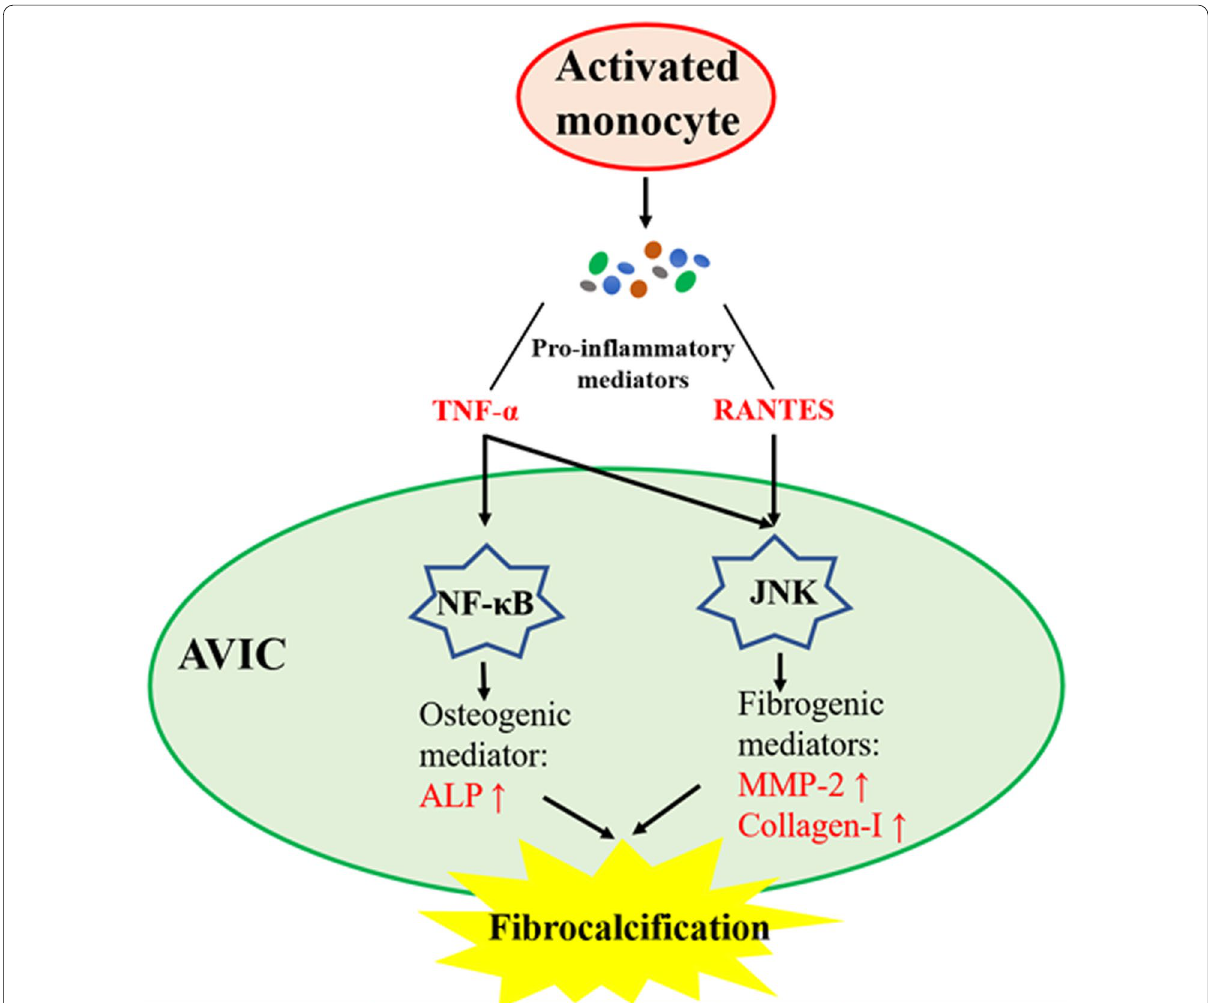
Fig. 6 Schematic diagram depicting the mechanism underlying AVIC fibrocalcification induced by medium conditioned by activated monocytes. Pro-inflammatory mediators produced by monocytes activated by TLR-2 agonist induce AVIC fibrocalcification involving up-regulation of fibrogenic and osteogenic mediators. RANTES contributes to the fibrogenic response induced by Pam3 CM through activation of JNK, and TNF-α mediates the pro-fibrogenic and pro-osteogenic effects of Pam3 CM through activation of both JNK and